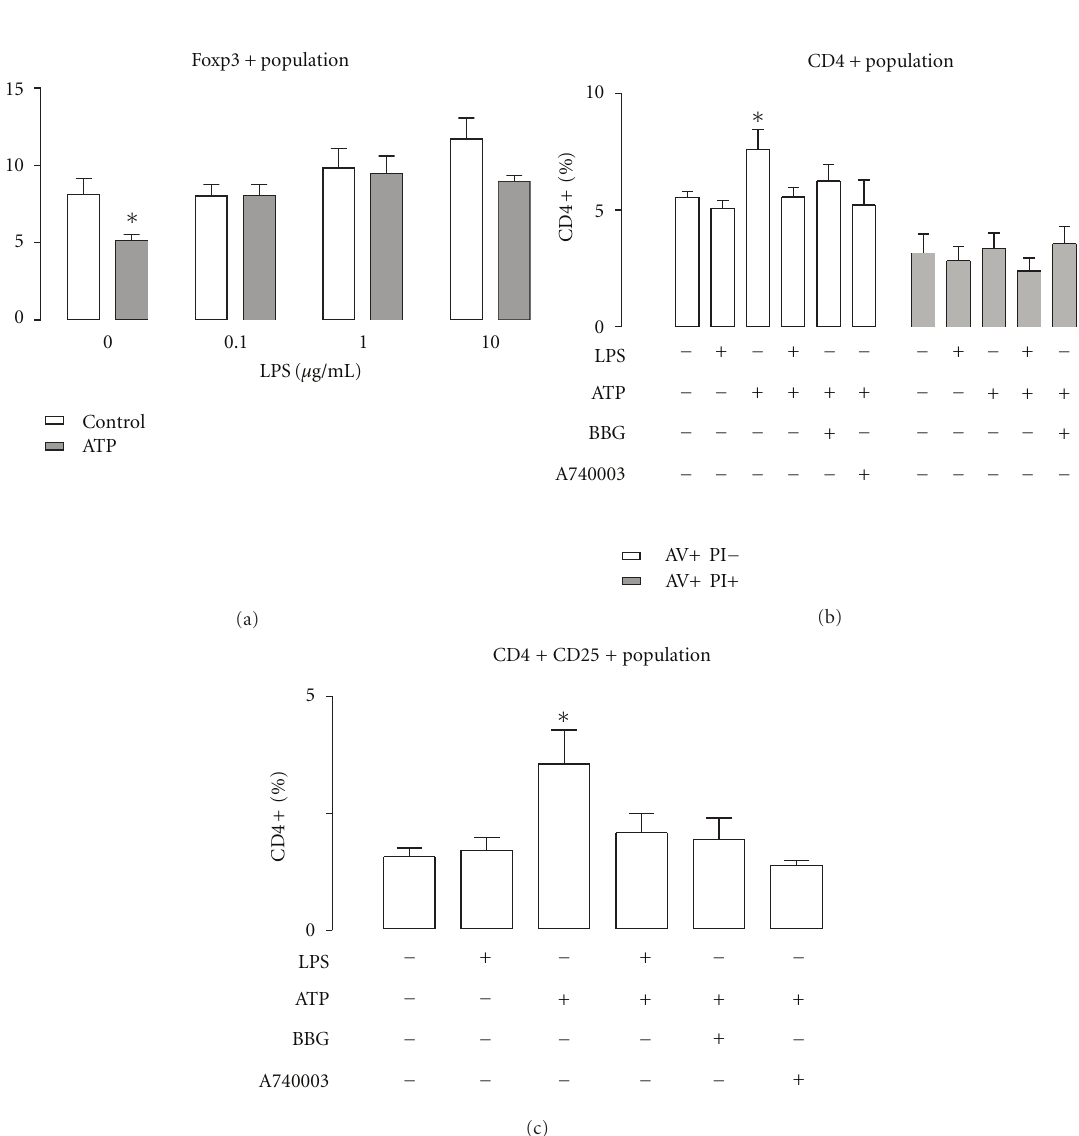
Figure 5: LPS protects from ATP-induced depletion and apoptosis in CD4+ CD25+ T-regulatory cells. (a) LPS abolishes the ATP-induced depletion of Treg’s population. ATP (60 μ M, gray bars) was applied for 30 min, 24 h before cell staining and flow cytometry. ∗ P < 0 . 05, Mann-Whitney test, n = 4. (b) E ff ects of LPS (1 μ g/mL) and BBG (100 nM, a P2X7R antagonist) in ATP-induced early apoptosis measured with annexin V (AV) assay. ATP (60 μ M) was applied for 30 min, 3h before cell staining and flow cytometry. Open bars correspond to the apoptotic population, whereas gray bars represent necrotic cells. ∗ P < 0 . 05, Mann-Whitney test, n = 4. (c) LPS and BBG inhibit the ATP- induced increase in CD4+ CD25+, annexin-positive population. ATP was applied for 30min, 3h before cell staining and flow cytometry. ∗ P < 0 . 05, Mann-Whitney test, n =